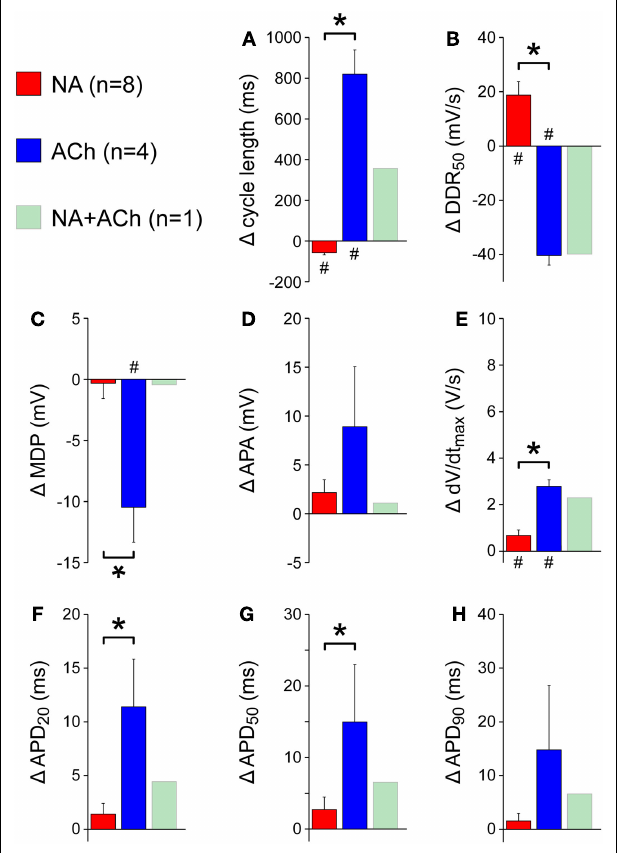
FIGURE 3 | Change in action potential parameters of isolated rabbit SA nodal myocytes in response to 1 μ M noradrenalin (“NA,” red bars), 1 μ M acetylcholine (“ACh,” blue bars), or a combination of both noradrenalin and acetylcholine (“NA + ACh,” green bars). Asterisks indicate significant differences between effects of noradrenalin and acetylcholine. Hashes indicate significant differences from control. (A) Change in cycle length. (B) Change in diastolic depolarization rate measured over the 50-ms time interval starting at maximum diastolic potential + 1mV (DDR 50 ). (C) Change in maximum diastolic potential (MDP). (D) Change in action potential amplitude (APA). (E) Change in maximum upstroke velocity ( dV / dt max ). (F) Change in action potential duration at 20% repolarization (APD 20 ). (G) Change in action potential duration at 50% repolarization (APD 50 ). (H) Change in action potential duration at 90% repolarization (APD 90